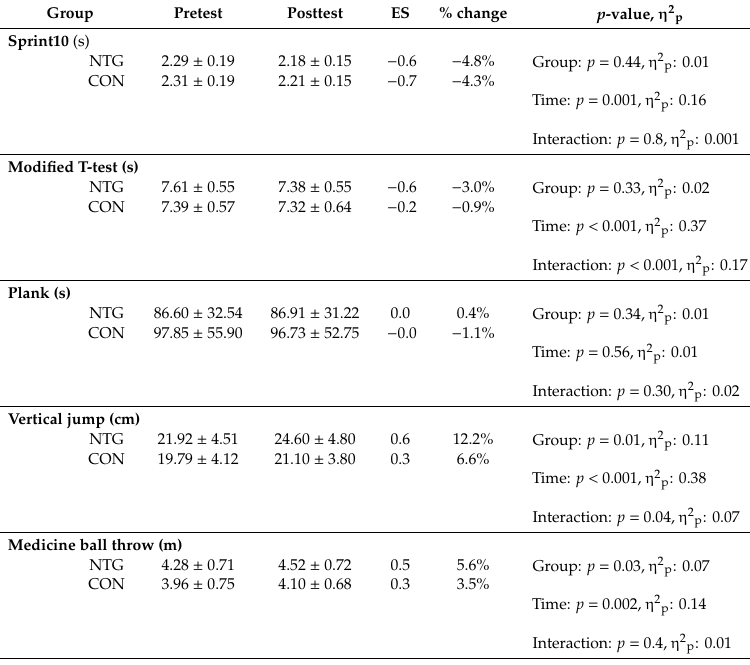
Table 4. Pretest and posttest results for physical